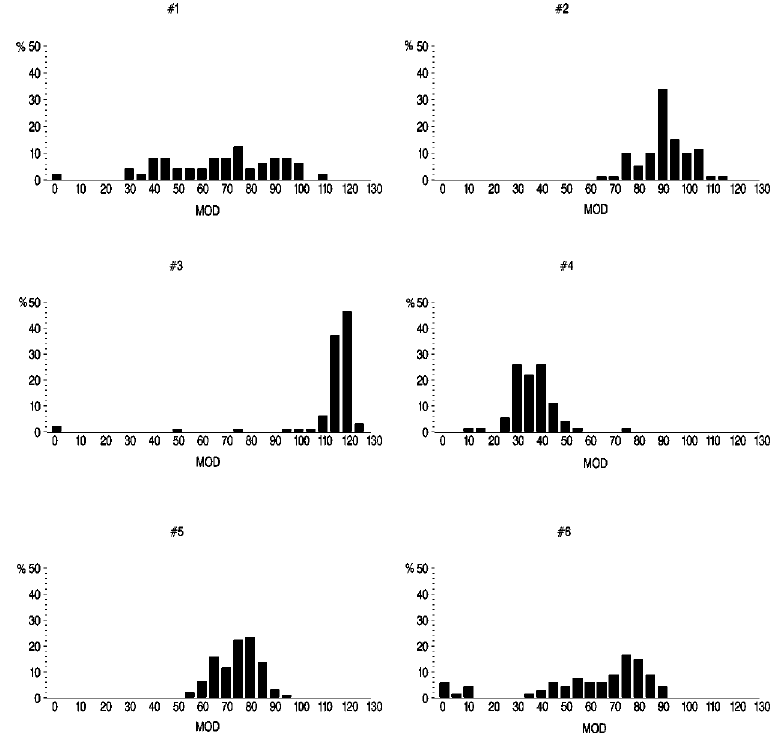
Fig. 1. The frequency distribution of staining intensity of c-erbB-2 protein of the six cases of BCA. The mean values of these distributions